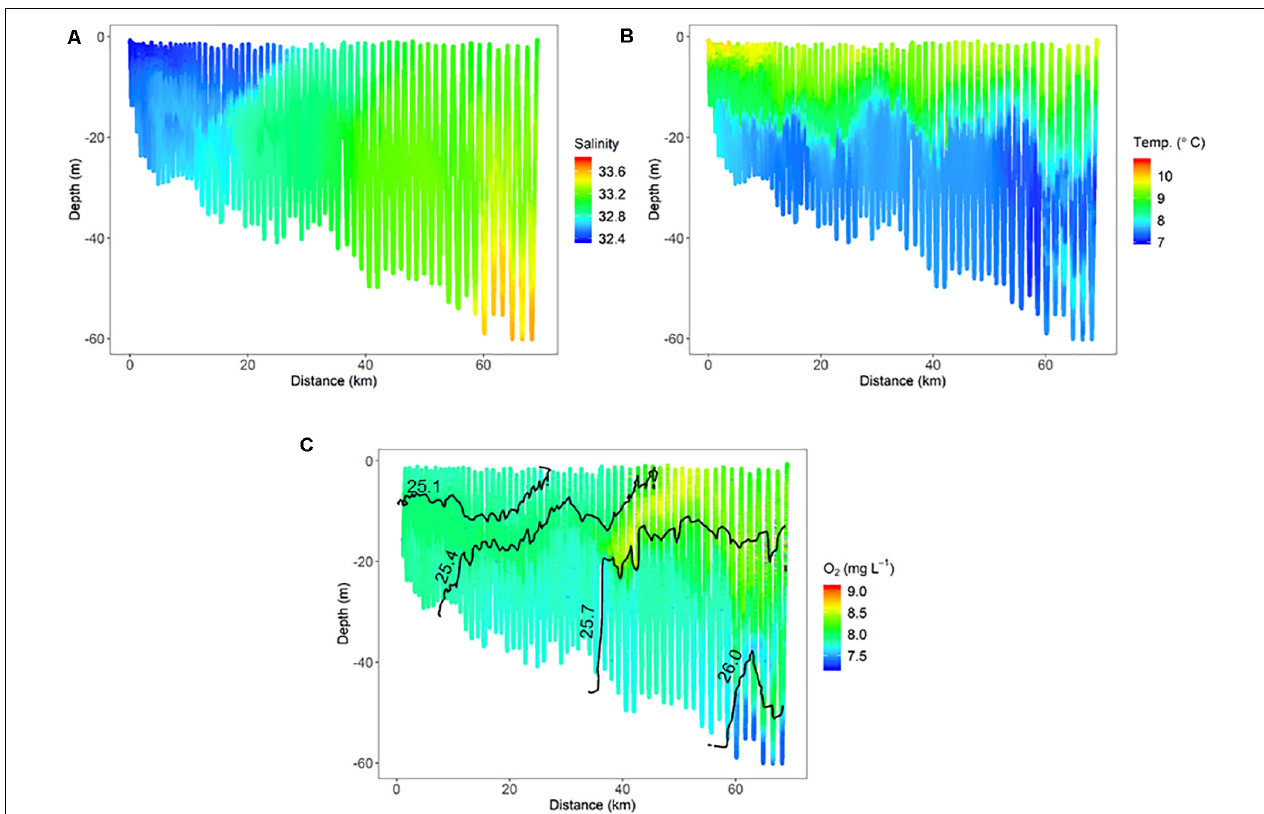
FIGURE 3 | Physical oceanographic conditions from ISIIS tow #1 including, (A) salinity, (B) temperature, and (C) dissolved oxygen. Isopycnals located in panel C (1025.1, 1025.4, 1025.7, and 1026.0 kg m − 3 ) are displayed as a reference to other figures.